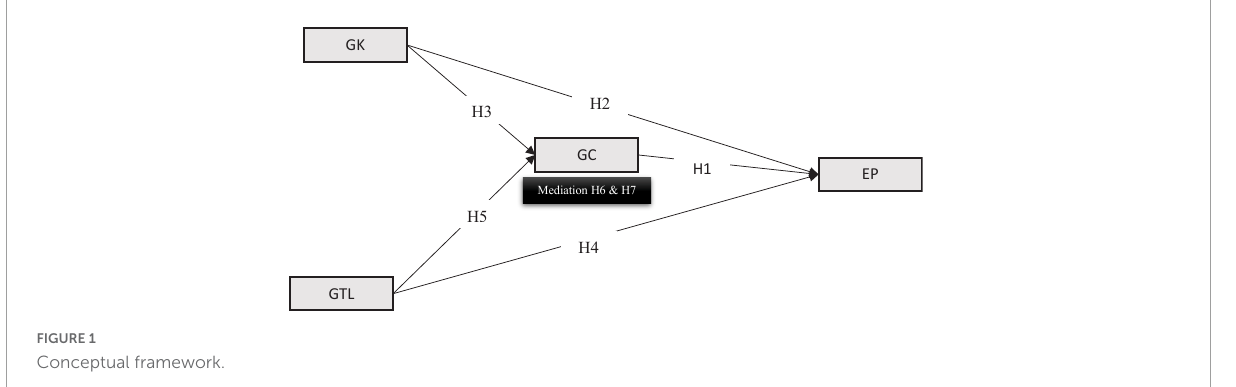
FIGURE1 Conceptual